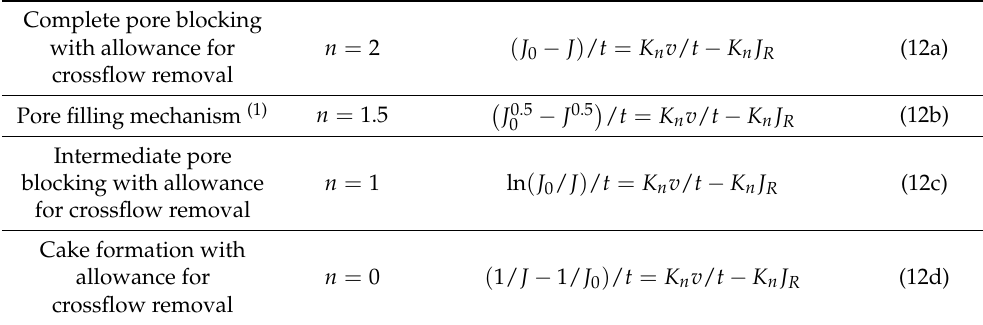
Table 1. Tabulated expressions permitting facile crossflow fouling